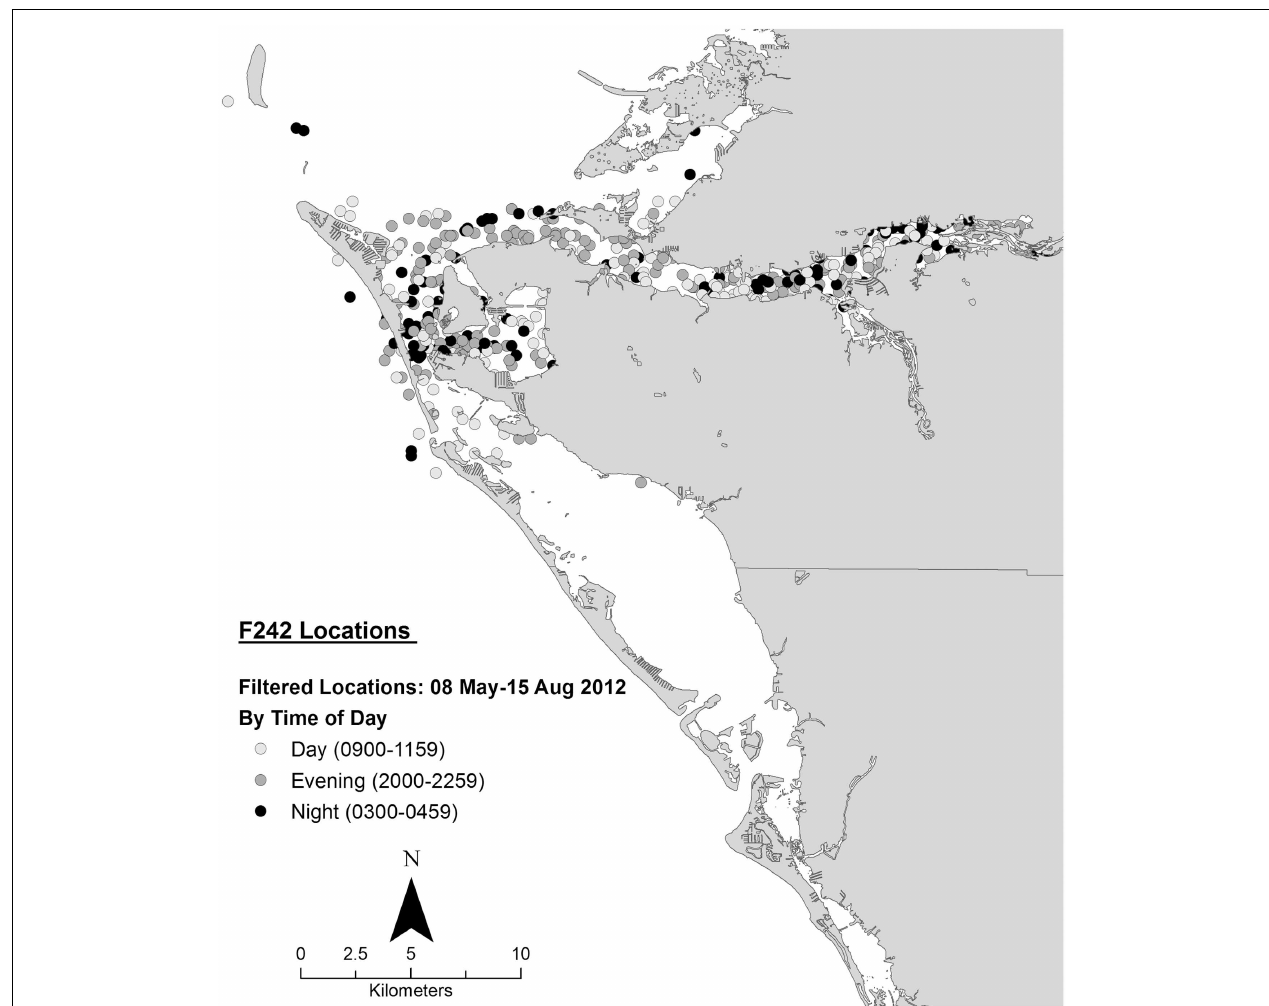
FIGURE 10 | Locations of bottlenose dolphin F242 relative to time of day during May–August 2012, from satellite-linked transmitter